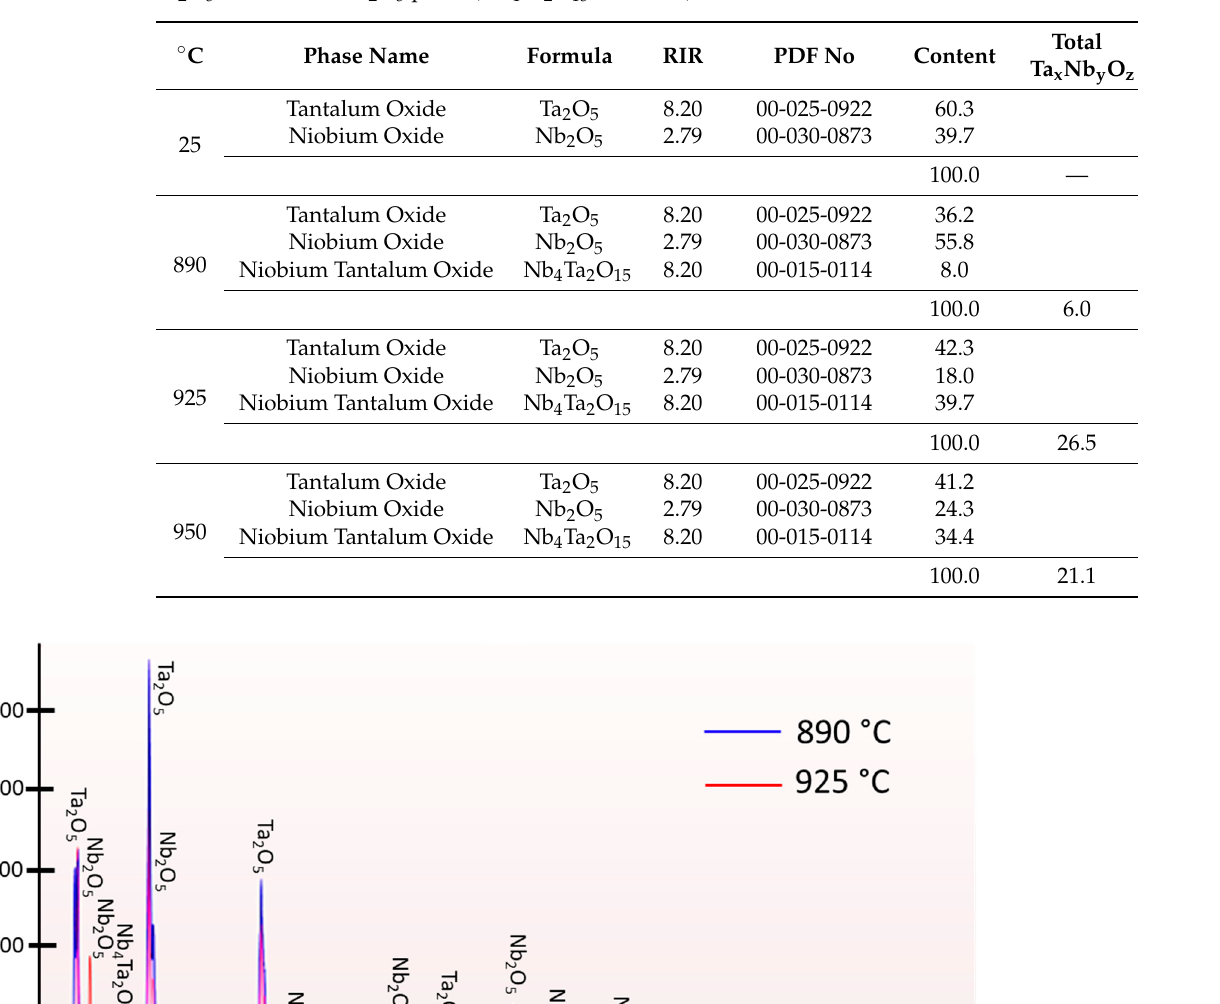
Table 9. Quantitative phase analysis results (WPF) from the high-temperature XRD scans of a 30 mol%